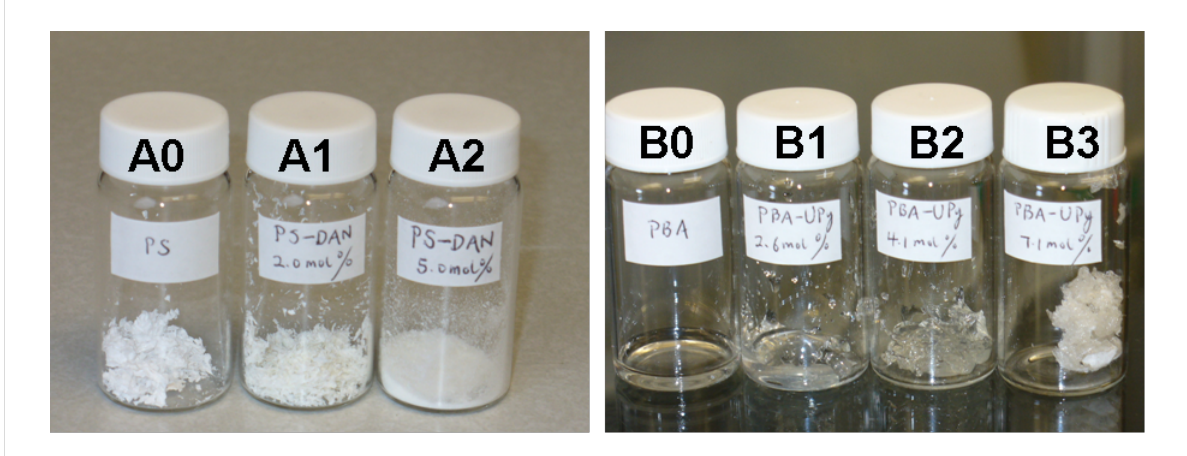
Figure 5: Physical appearance of DAN-modified PS and UPy-modified PBA. Left: A0 = PS, A1 = PS-DAN 2.0 mol %, A2 = PS-DAN 5.0 mol %. Right: B0 = PBA, B1 = PBA-UPy 2.6 mol %, B2 = PBA-UPy 4.1 mol %, B3 = PBA-UPy 7.1 mol %.